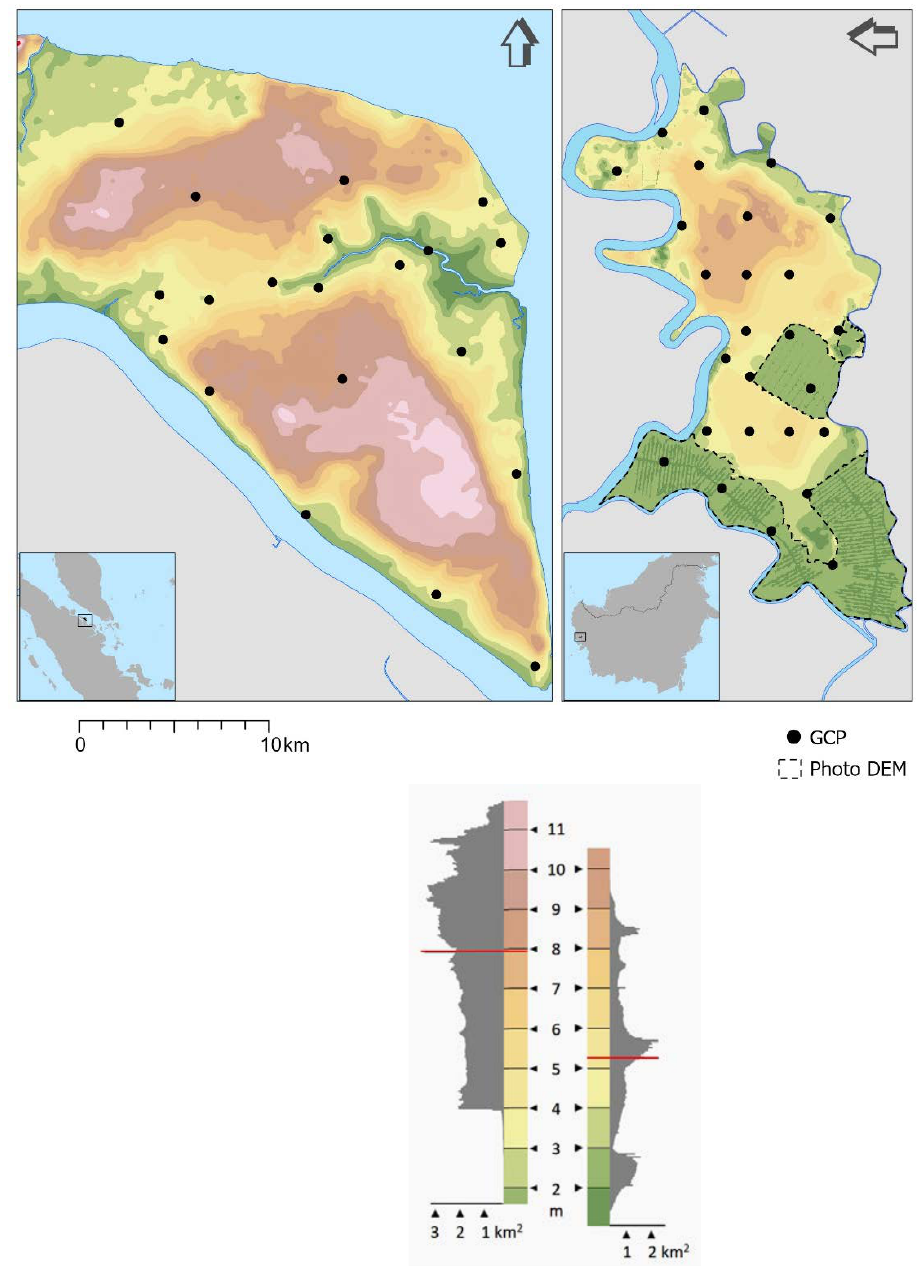
Figure 3. Ground Control Points (GCPs), peat surface elevation (m), peat extent at each surface elevation level (km 2 ) and mean surface elevation (red line) at Bengkalis (left) and Kubu Raya (right). At Bengkalis, coastal erosion has removed peat below 4 m. Bengkalis DTM is derived from airborne IFSAR. Kubu Raya DTM is derived from satellite SAR for higher elevations and from ortho-photogrammetric data at lower elevations (within dashed